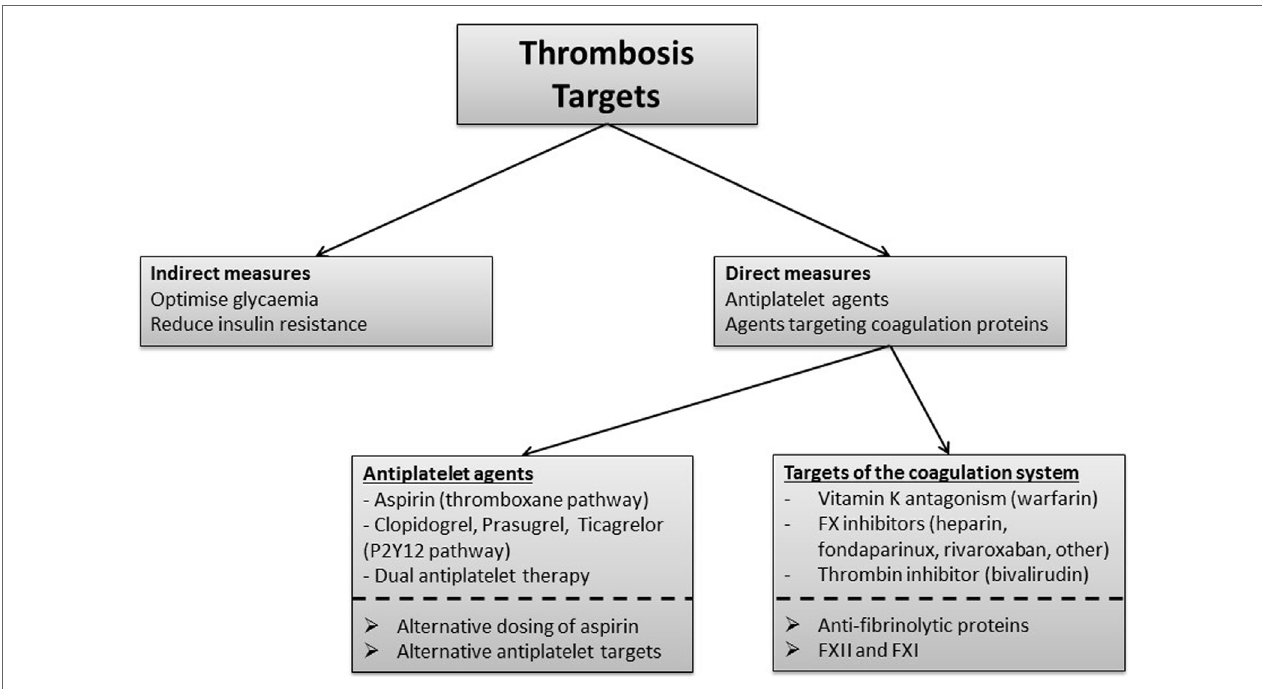
FigURe 5 | Thrombotic pathways that represent current and potential therapeutic targets in diabetes. Indirect measures to improve the thrombotic environment in diabetes focus on optimizing glycemic control by lowering glucose levels while avoiding hypoglycemia and also by reducing insulin resistance. Antiplatelets and agents that target the coagulation system comprise the main direct measures to manage the thrombotic environment in diabetes. Aspirin targets the thromboxane pathway and is also used in combination with clopidogrel, prasugrel, or ticagrelor which target the P2Y12 pathway. Alternative antiplatelet targets are under consideration. Vitamin K antagonism reduces thrombosis risk but is associated with high risk of bleeding when combined with antiplatelet therapy, and therefore, not routinely used for atherothrombotic disease. Inhibitors of coagulation proteins FX and thrombin, such as heparin and direct oral anticoagulants, represent agents with promise in diabetes while targeting factor (F)XII and FXI requires careful future evaluation. Alternative dosing of aspirin and reduction of incorporation of antifibrinolytic proteins into the clot may represent new approaches to improve clinical outcome in patients with